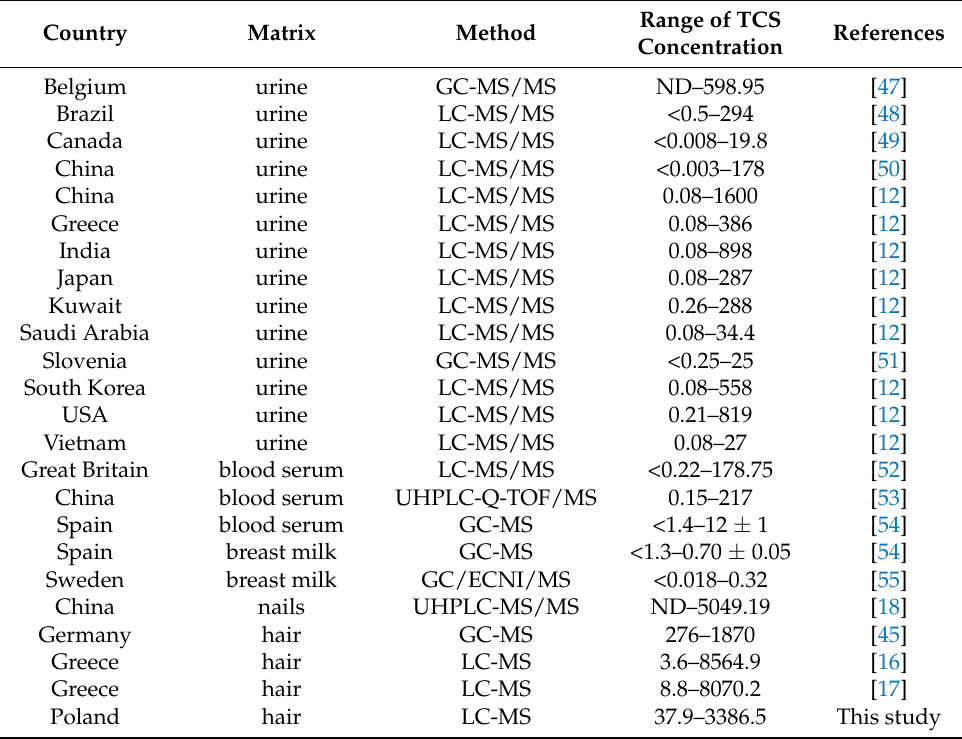
Table 3. TCS concentration levels in humans in light of selected previous studies. Concentrations in ng/mL for liquid samples and in ng/g for solid samples.